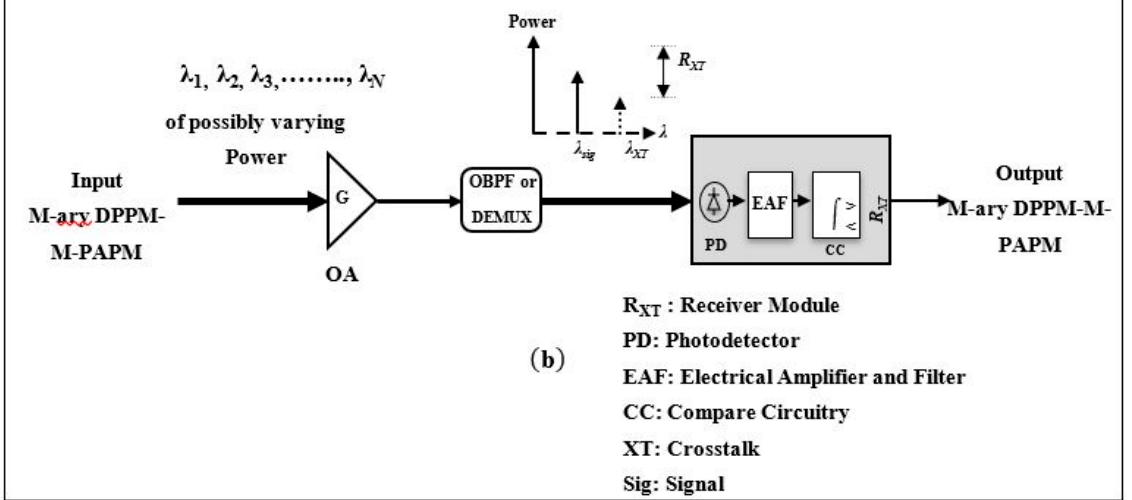
Figure 1. System model for 8 channels PON-DWDM-HFFSO for OOK-NRZ/M-ary DPPM-M-PAPM under moderate turbulence (MT), strong turbulence (ST), and weak turbulence (WT): ( a ) proposed framework for interchannel crosstalk (ICC) evaluation and ( b ) schematic of the receiver system. We reproduced it from [9].